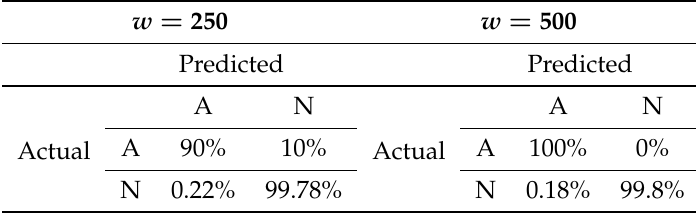
Table 2. Confusion matrix for A (attack) and N (normal)